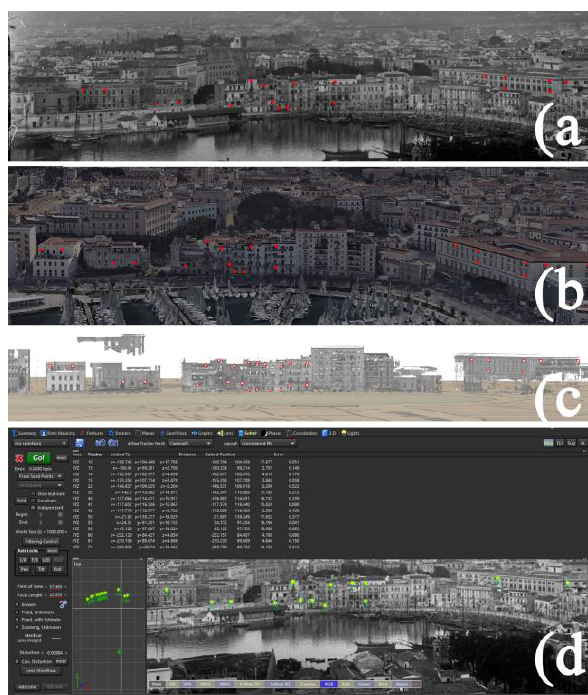
Figure 3: Camera pose estimation. The points used for camera